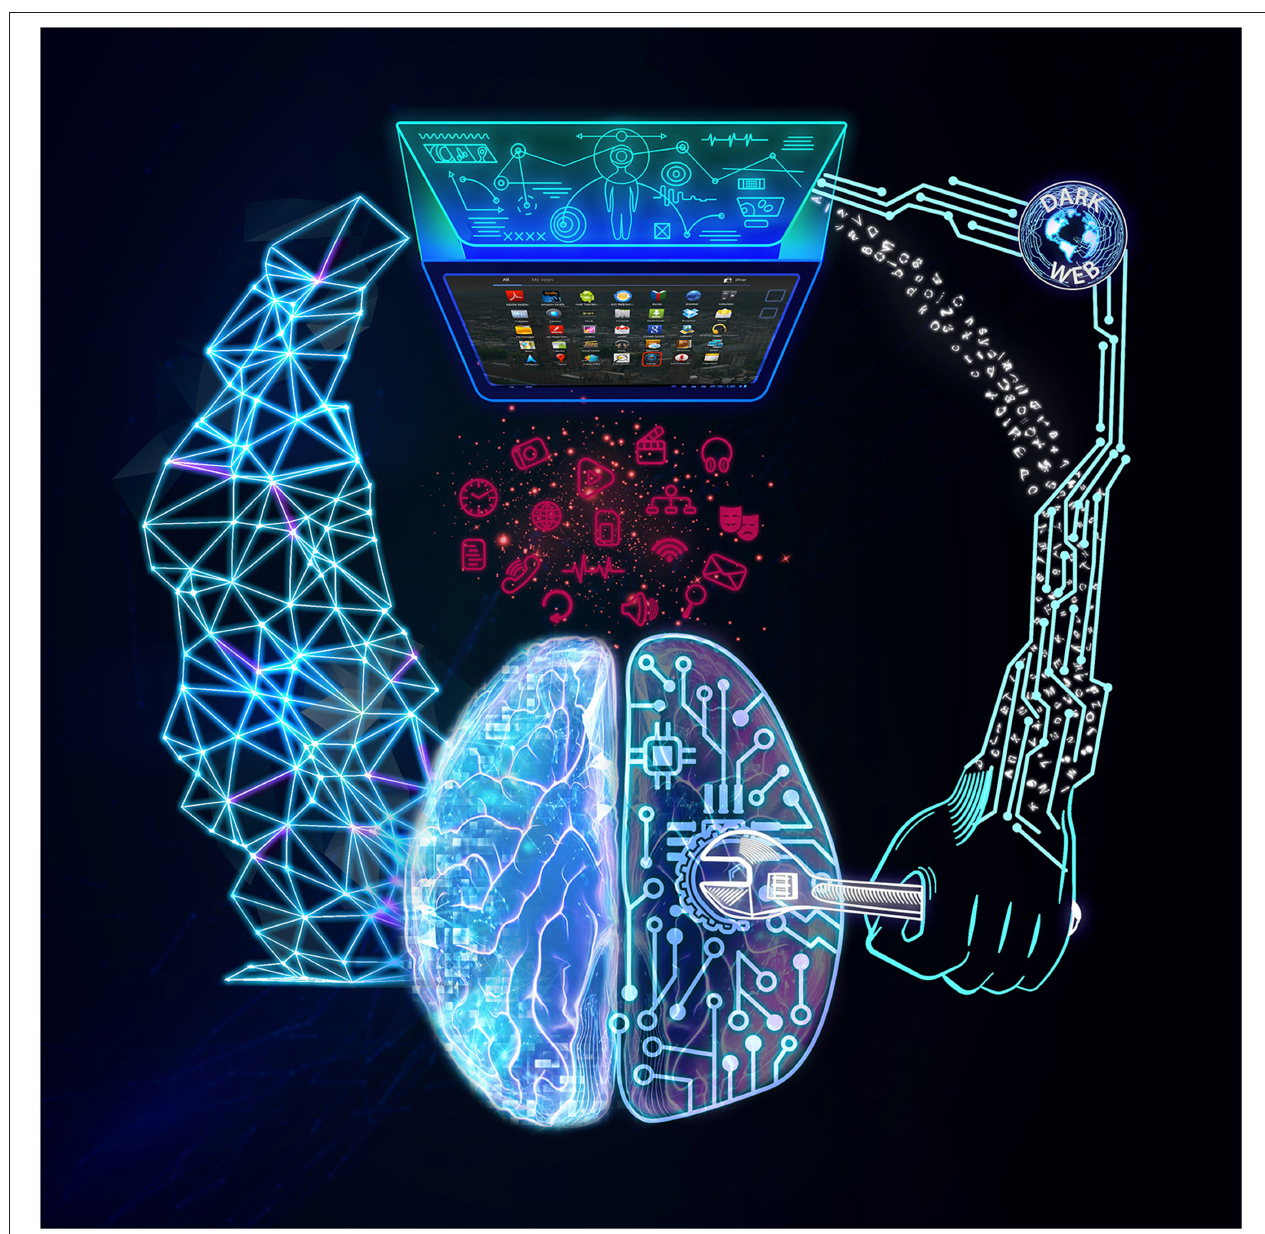
FIGURE 1 | Digital Surveillance Capitalism. On the left, you see the potentially beneficial digital phenotyping, where clients’ or patients’ information are collected through their apps to better serve them. On the right, you see the potentially unintended consequences of the intersection of digital phenotyping, dark web, and digital neuromarketing where profiteers may use the collected personal information for their illegal and unethical financial gain. The figure also shows the bidirectional nature of these communications; such that, the dark web that is fed by digital phenotyping and digital neuromarketing; meanwhile, can simultaneously strengthen their hazardous